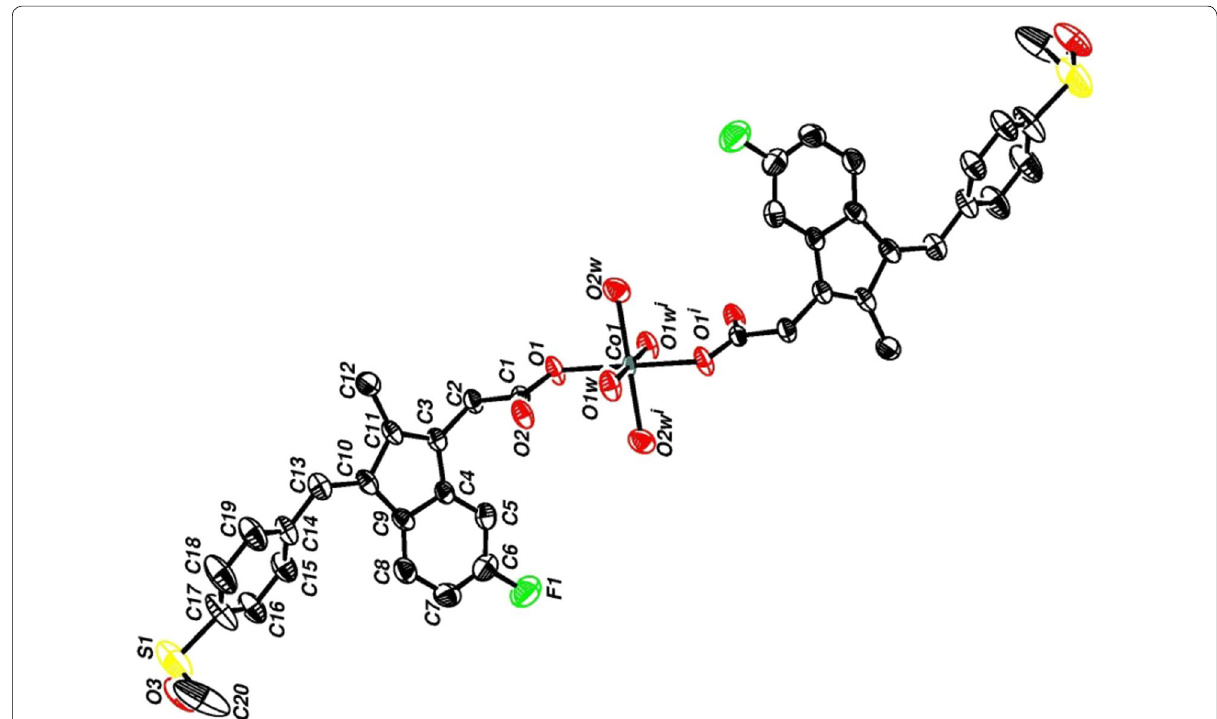
Fig. 2 The molecular structure view of 1 showing the atom labeling scheme